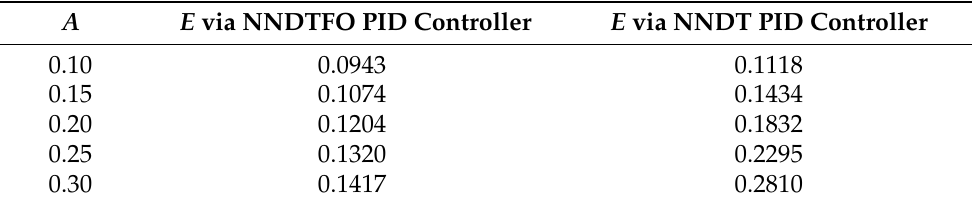
Table 2. Index E for different parameters A with ω = 0.02 via two types of controller.